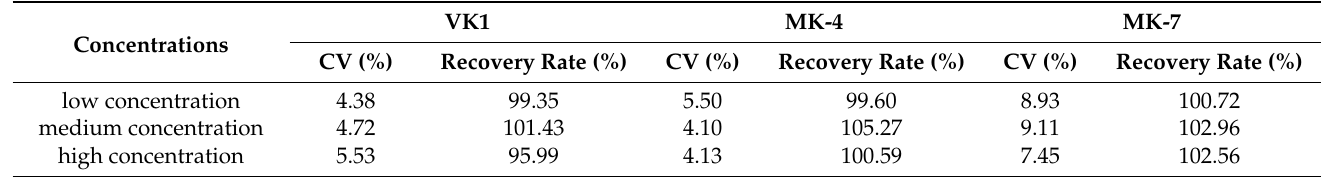
Table 1. The result of quality control for VK1, MK-4 and